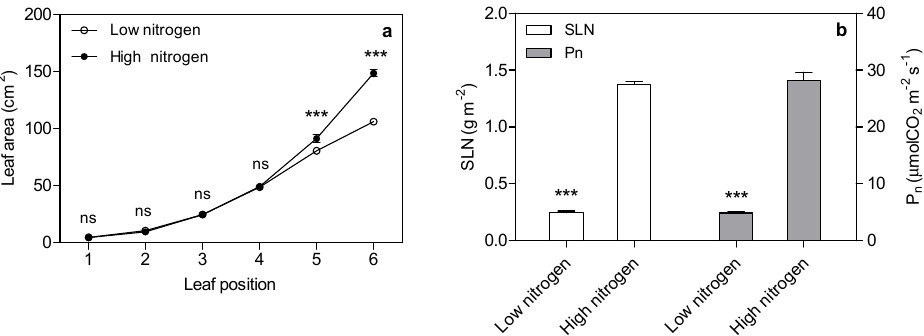
Figure 1. Effect of nitrogen supply on leaf area ( a ), specific leaf nitrogen (SLN) and photosynthetic rate ( p n ) of the sixth leaf in maize ( b ). Bars denote the standard error (SE) of the mean. ns: not significant ( p > 0.05); ***: significant at p < 0.001.